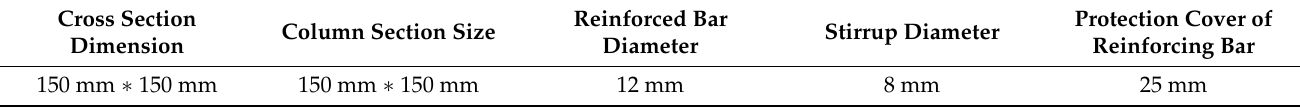
Table 7. Frame structure parameter.